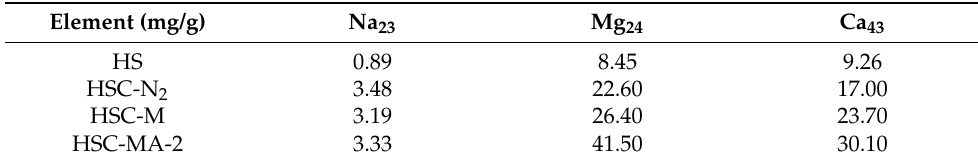
Table 2. The element composition of the biochar measured by ICP-MS. Element (mg/g) Na